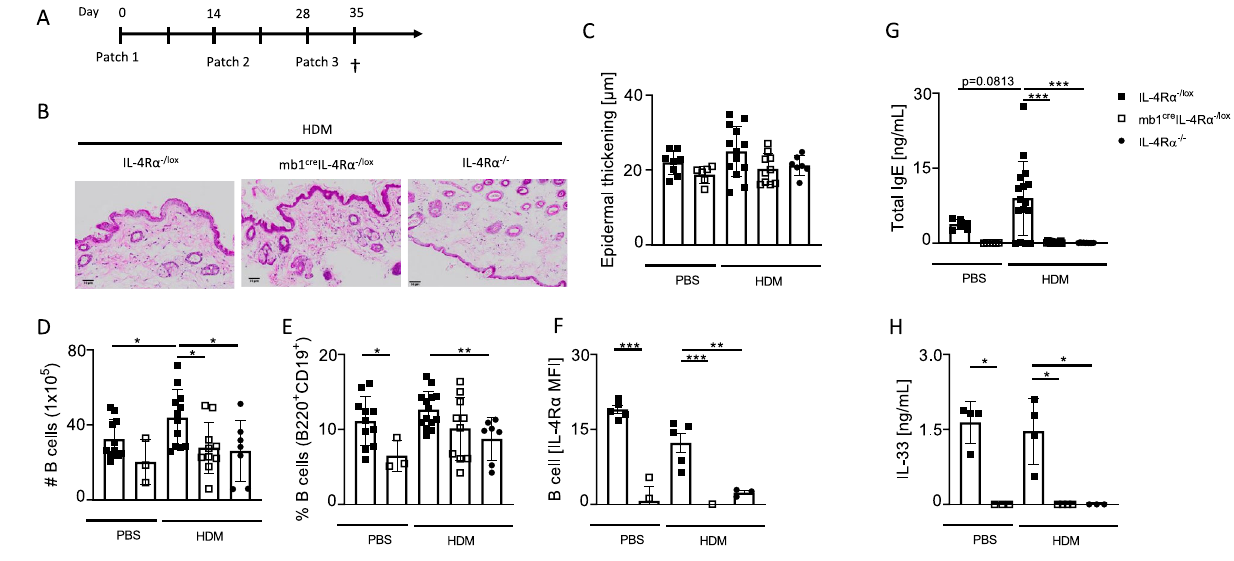
Figure 4. Epicutaneous sensitization with HDM induces insufficient skin inflammation, but IgE-dependent IL-4R ⍺ expression in B cells. Shaved mice (mb1 cre IL-4R ⍺ −/lox , IL-4R ⍺ −/lox littermate controls and IL-4R ⍺ −/− ) were epicutaneously sensitised as in Fig. 1. ( A ) H&E-stained images showing epidermal thickening, scale bar 50 μm. ( B ) Epidermal thickening using QuPath software. ( C ) Total B cell numbers in the iLNs. ( D ) Frequency of